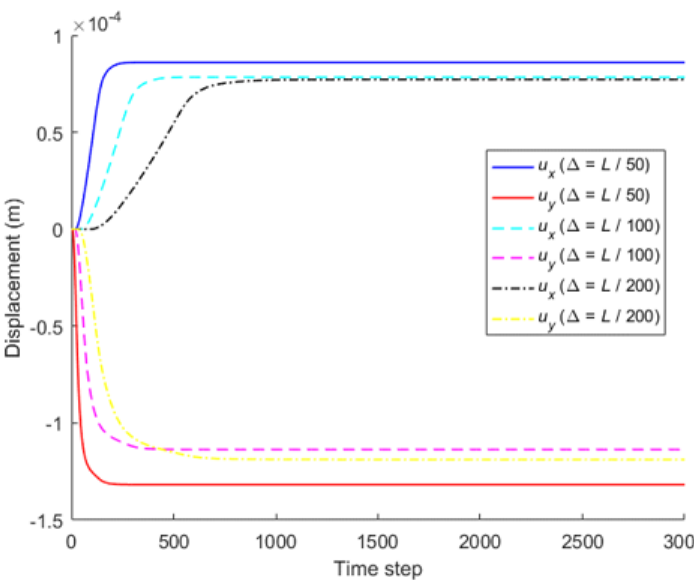
Figure 3. δ -convergence of displacement with time step at different nodes.